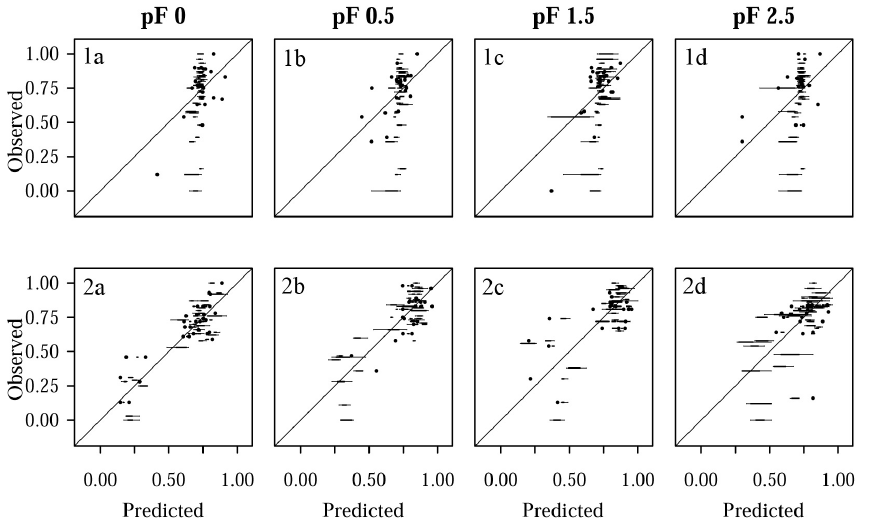
Figure 8. Comparison of predicted and observed water retention values for Quinuas, showing (1a–d) models with tuning by grid search and (2a–d) models with parameter tuning by differential evolution for (1a, 2a) pF 0, (1b, 2b) pF 0.5, (1c, 2c) pF 1.5, and (1d, 2d) pF 2.5. Each boxplot is based on five values resulting from five CV repetitions. Predicted and observed values were scaled to the range [0,